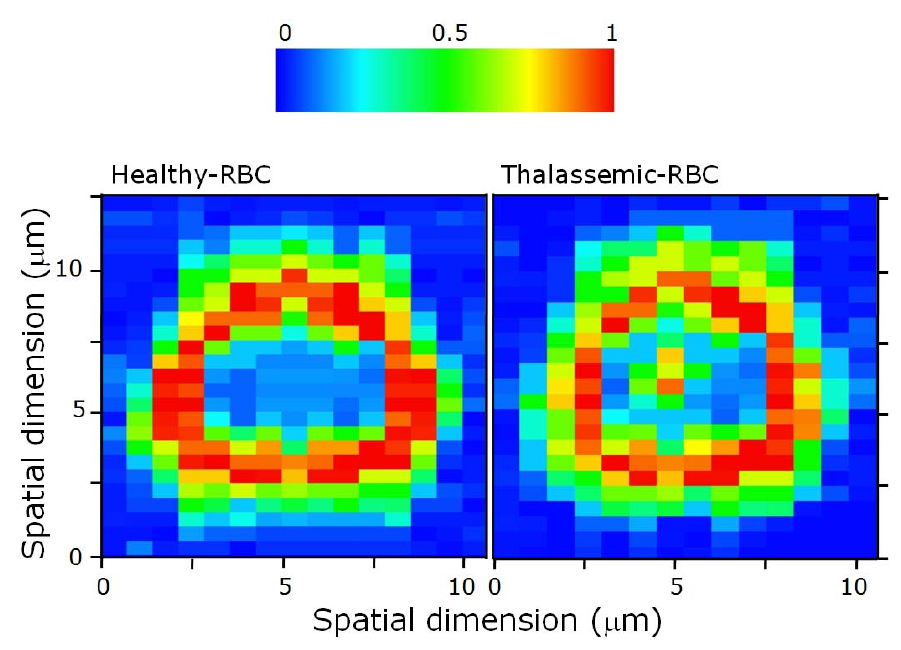
Figure 7. Raman image of a healthy and a thalassemic RBC obtained by reconstructing the Hb distribution along the cell equatorial